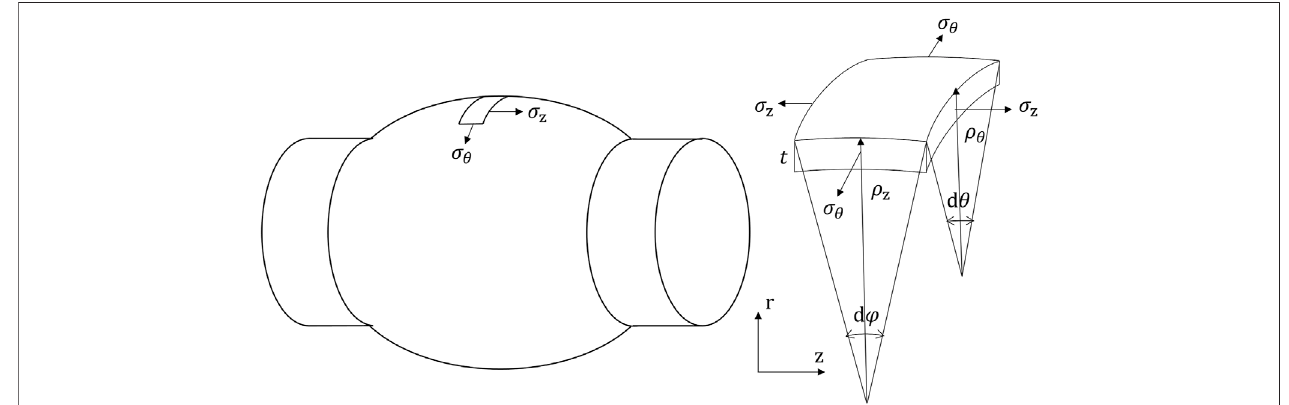
FIGURE 3 | In fi nitesimal element at the hydro-bulging tube ’ s